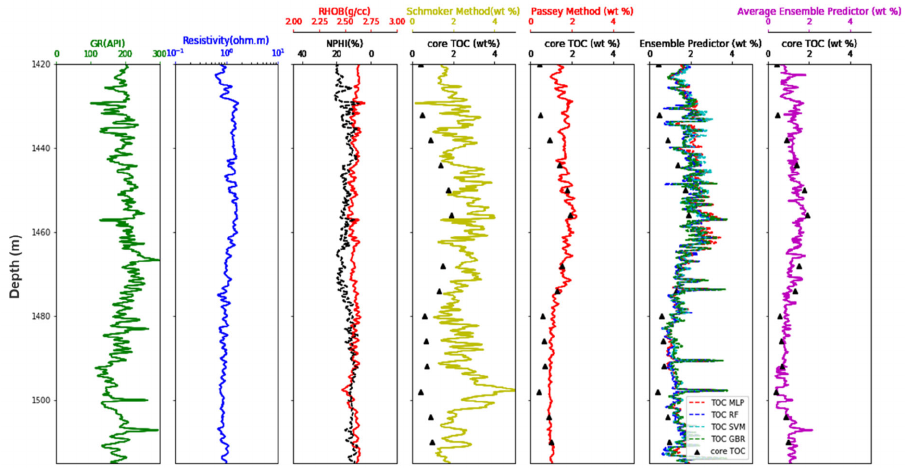
Figure 15. Comparison of different TOC estimation methods on a test well of the Goldwyer shale formation. Track 1, 2, and 3 are showing GR, logarithmic of deep resistivity, and combination of RHOB and NPHI, respectively. The last four tracks present Schmoker, Passey, four ensemble learning models, and an aggregated ensemble model, estimating the TOC profiles, respectively. Core TOC (black triangle) is also overlaid on each of the last four tracks. In track 6, four ensemble model predicted TOC are compared, and there is significant variation of prediction capability along the well where the combination of four ensemble model in track 7 provides much better followed core TOC value.